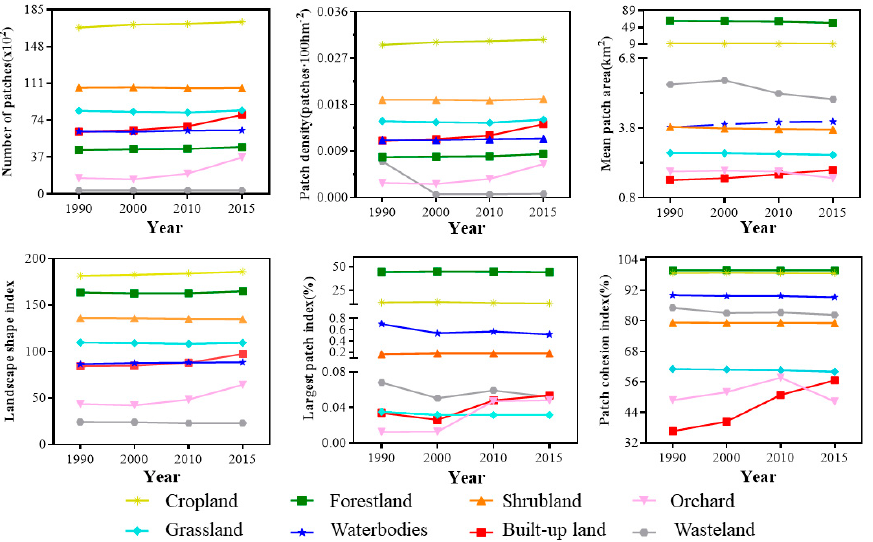
Figure 7. Landscape metrics on each type of land use in the MRYRR from 1990 to 2015.